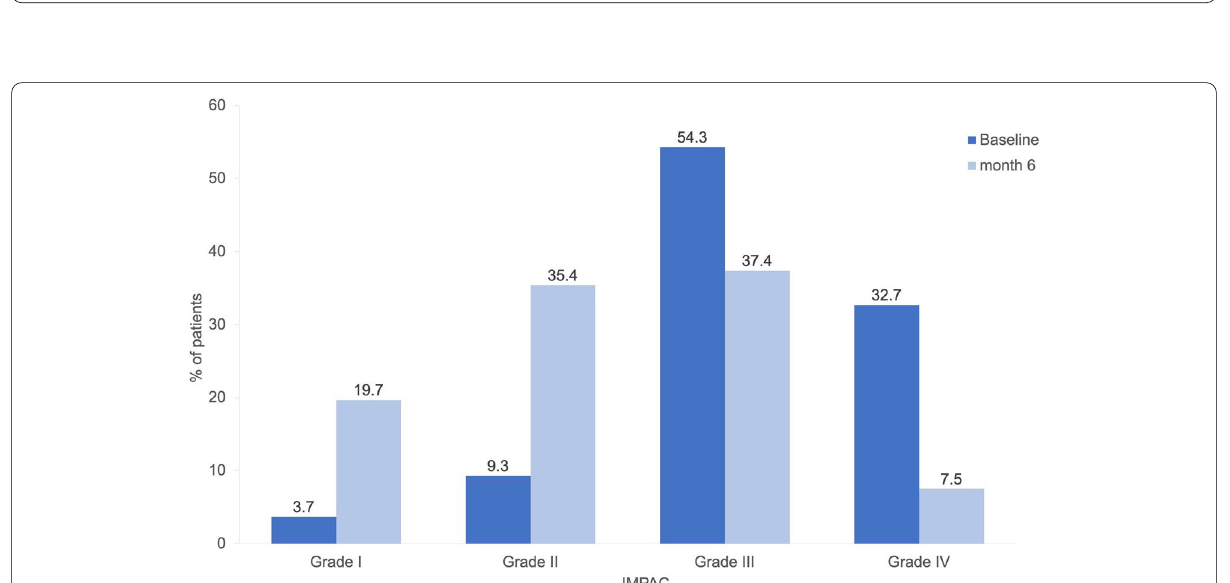
Fig. 3 Mean mMIDAS score at baseline and after 6 months per migraine type ( N migraine; mMIDAS: modified migraine disability assessment